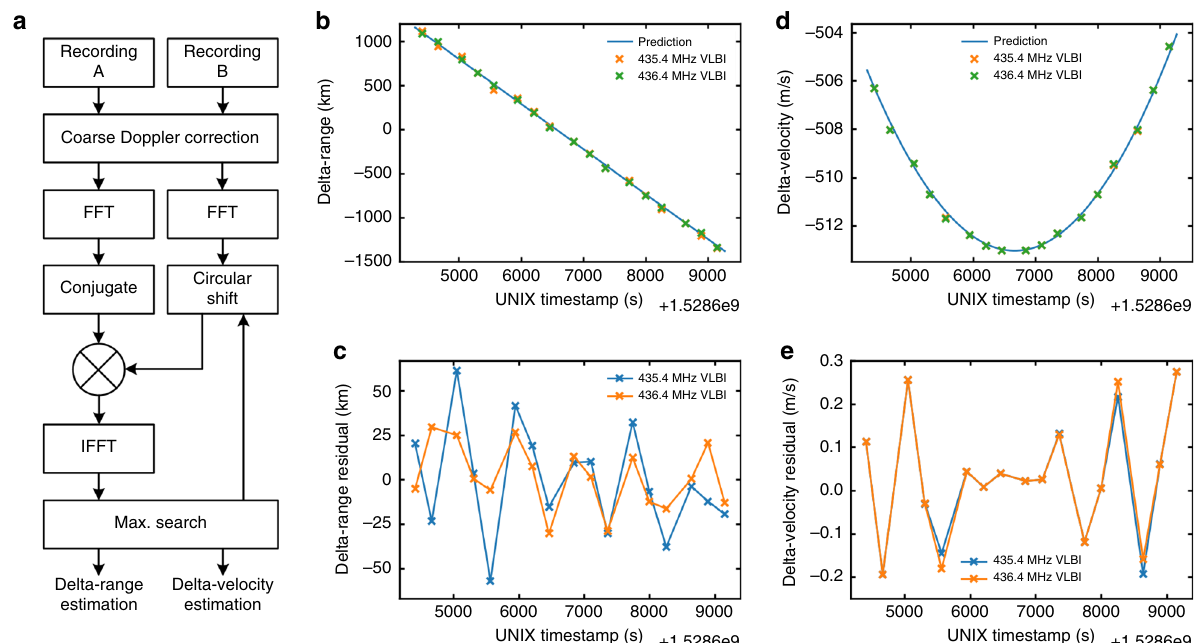
Fig. 6 Results of the fi rst VLBI experiment with Longjiang-2. a Block diagram of VLBI signal processing. b Delta-range result from VLBI comparing with prediction from CDSN elements. c Delta-range residual result from VLBI. d Delta-velocity result from VLBI comparing with prediction from CDSN elements. e Delta-velocity residual result from